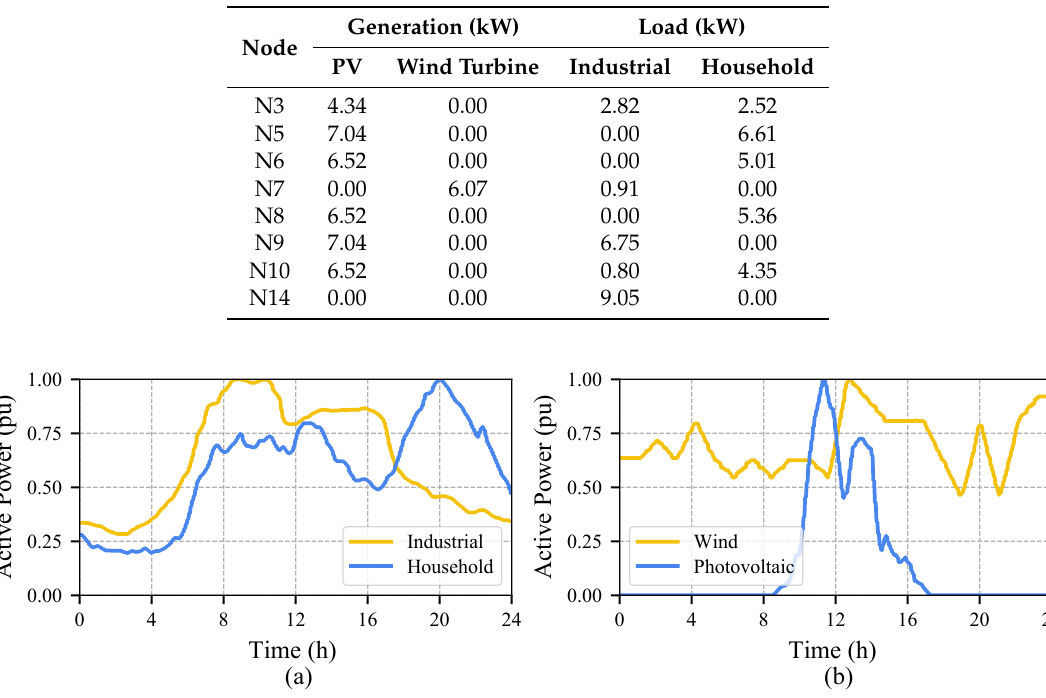
Table 2. Peak power of loads and generators connected in each node of the MV scaled-down distribution network.